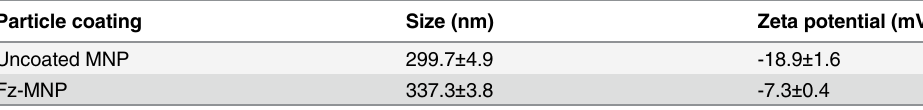
Table 1. Particle size and surface charge after antibody coating. Particle